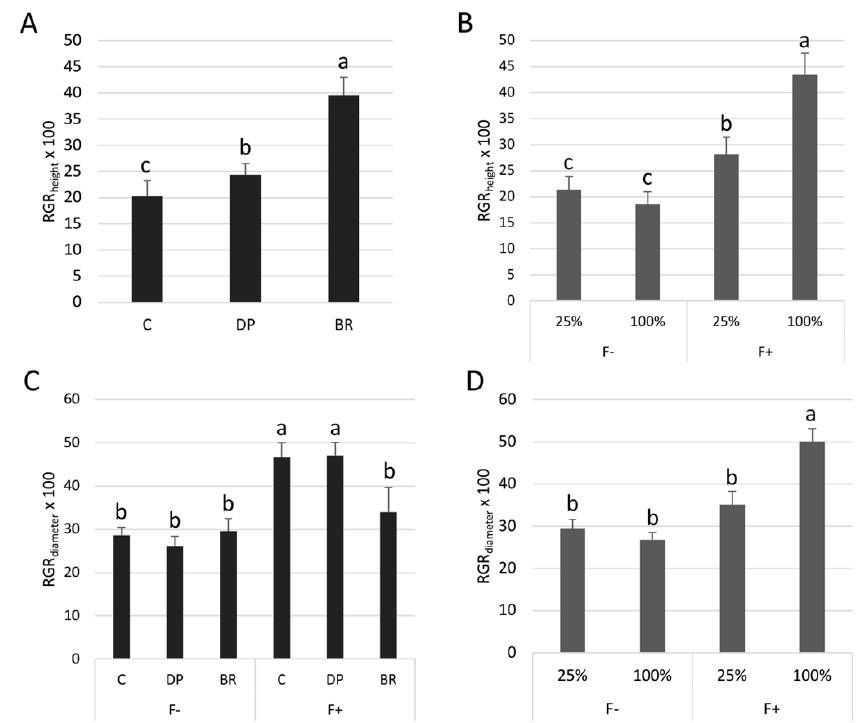
Figure 2. Relative growth rate in height (RGR height ) of black spruce seedlings according to ( A ) stock types and ( B ) irrigation (25% or 100% field capacity) × fertilization (F − without and F+ with fertilization) over one growing season. Relative growth rate in diameter (RGR diameter ) of seedlings according to ( C ) stock type × fertilization and ( D ) irrigation × fertilization over one growing season. Bars with the same letter indicate a non-significant difference at P ≤ 0.05.